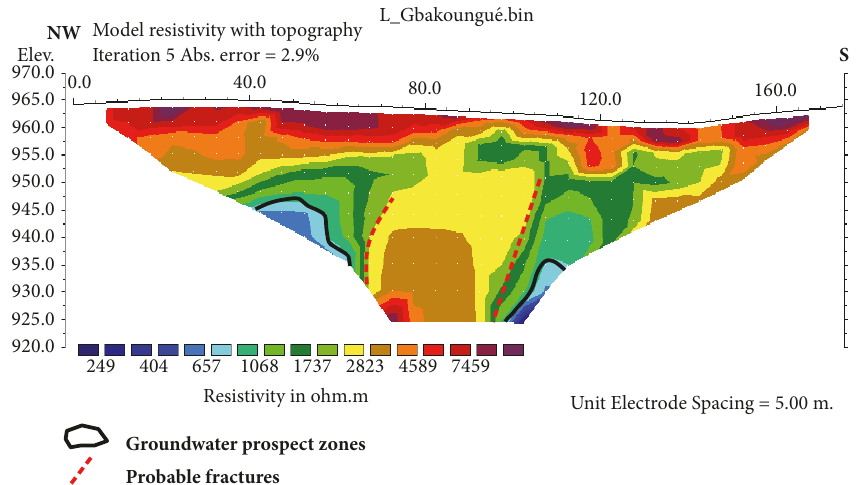
Figure 4: Inverse resistivity model along profile 1.